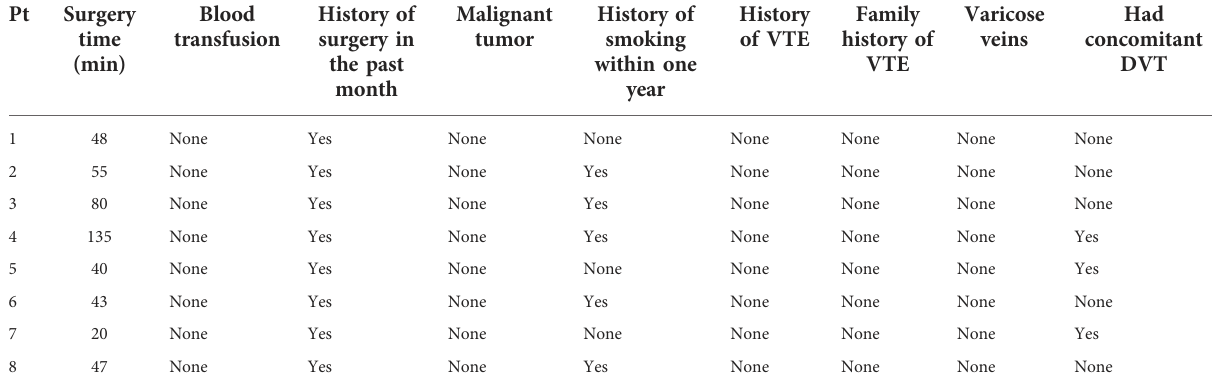
TABLE 3 Main risk factors related to